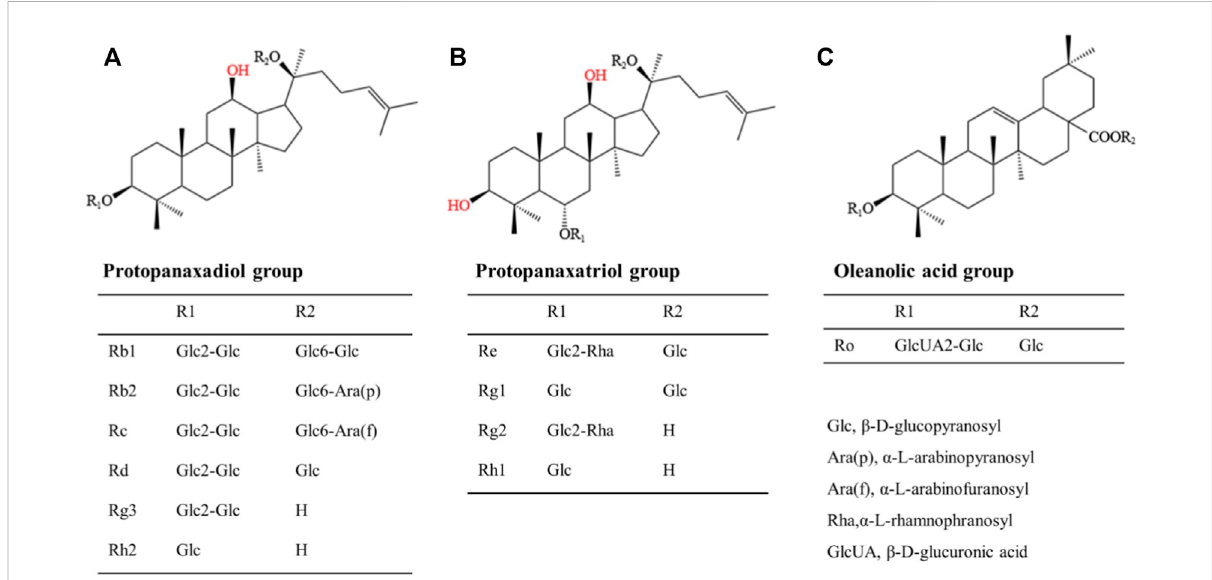
FIGURE 2 Structural formula of three kinds of ginsenosides. (A) : Protopanaxadiol group includes Rb1, Rb2, Rc, Rd, Rg3, Rh2, etc; (B) : Protopanaxatriol group includes Re, Rg1, Rg2, Rh1, etc; (C) : Oleanolic acid group includes Ro, etc.